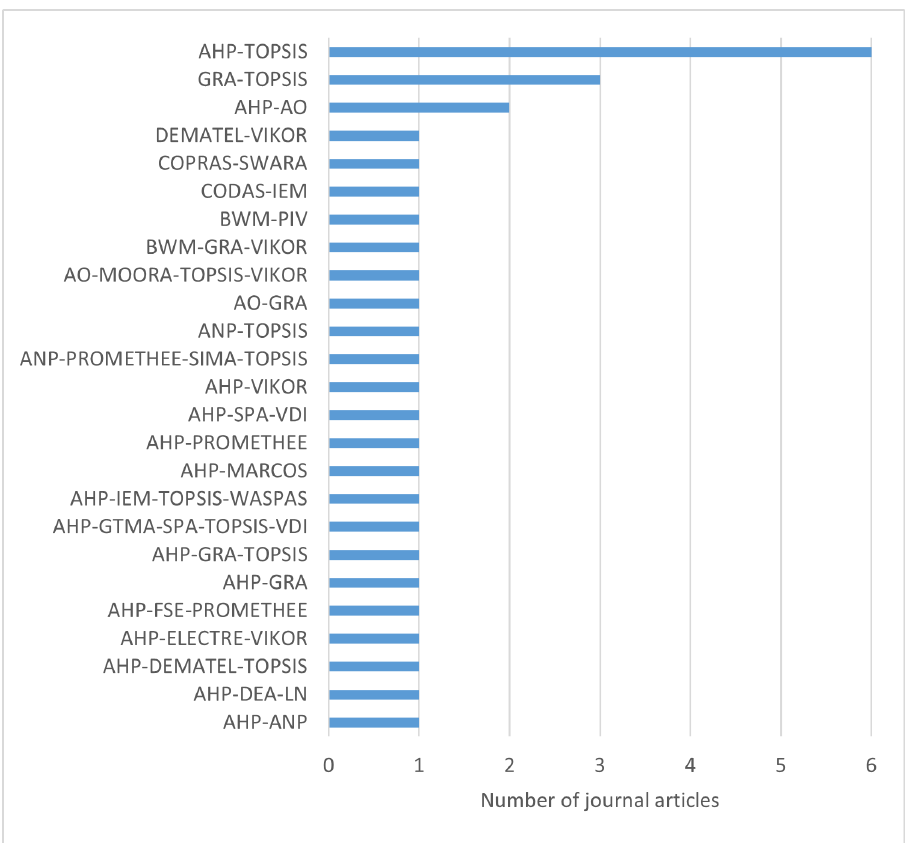
Figure 7. Distribution of the hybrid